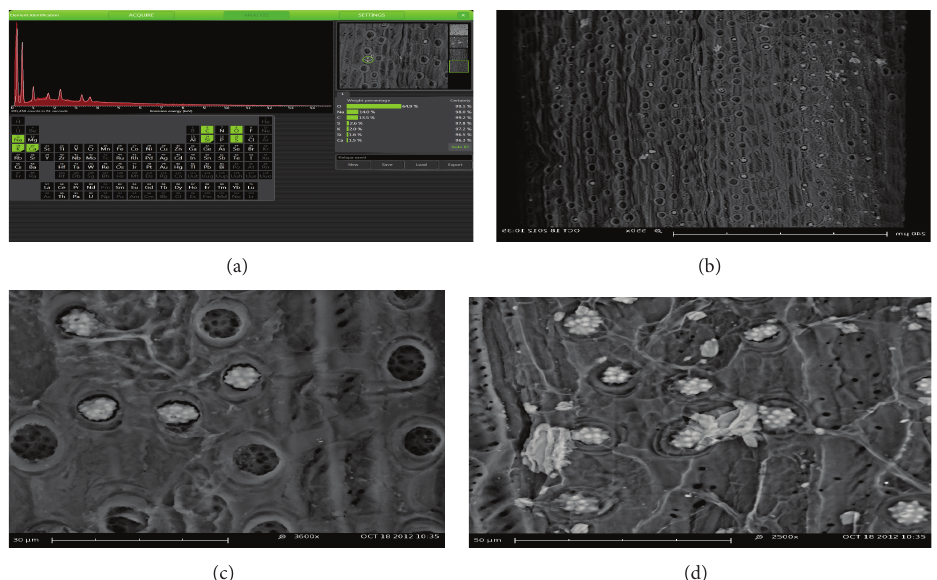
Figure 2: (a) EDX micrograph and (b–d) SEM micrographs of different magnifications.